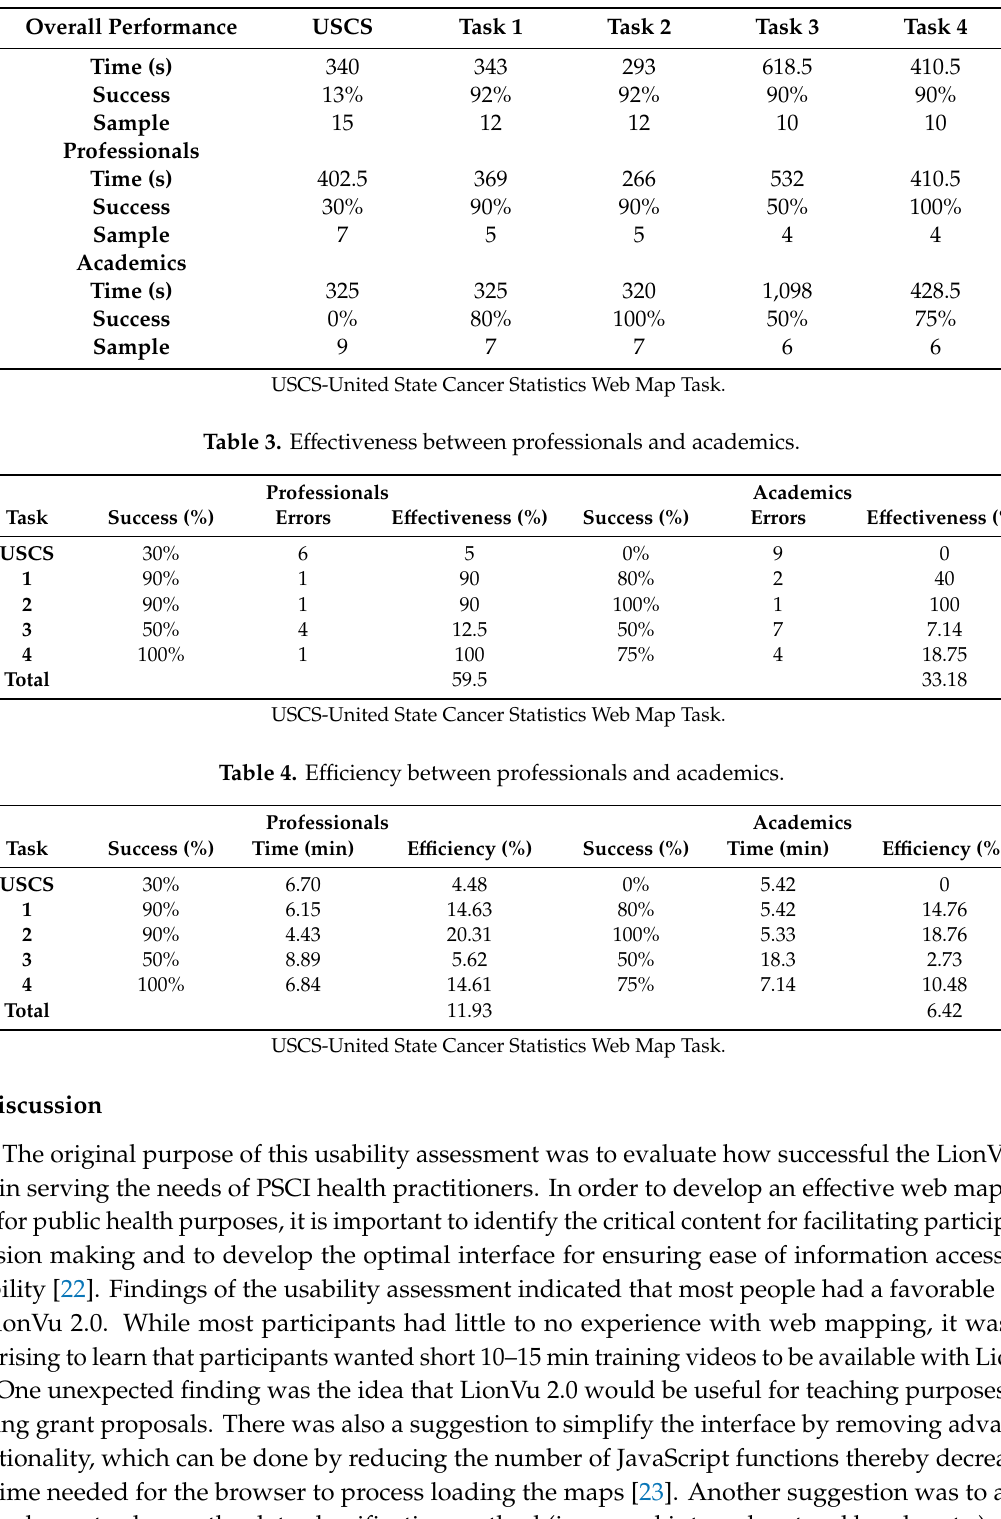
Table 2. Performance in median time and success between professionals and academics.